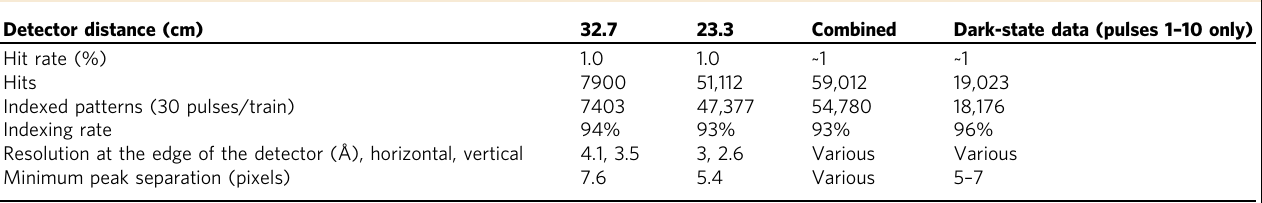
Table 1 Data collection statistics for PSI MHz SFX at the EuXFEL Detector distance (cm)